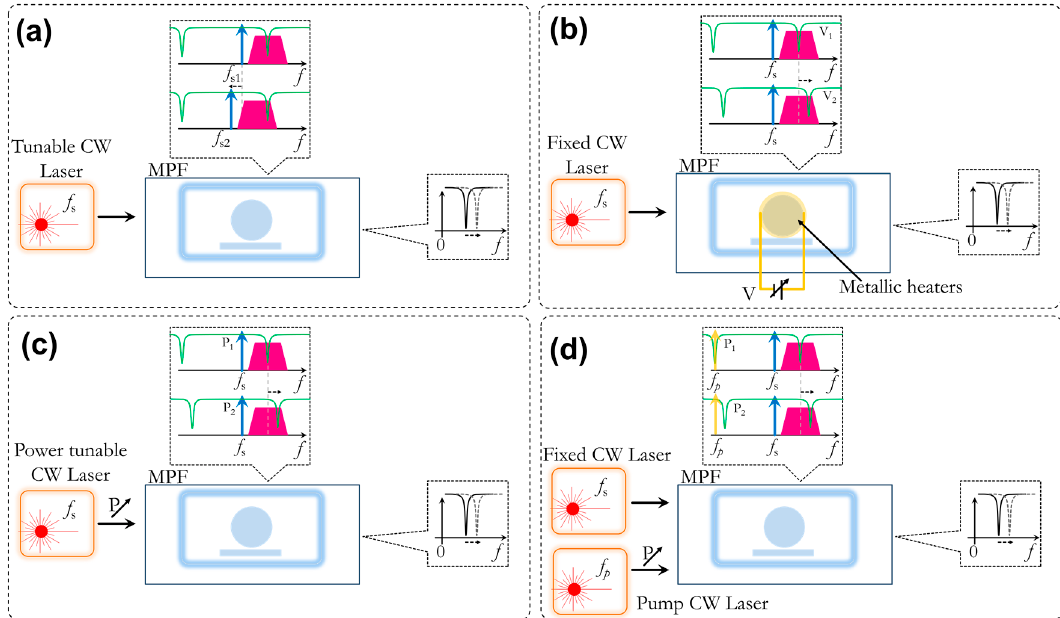
Figure 16. General frequency-tuning mechanisms for MPFs. ( a ) Tuning the optical carrier wavelength using a wavelength-tunable continuous wave (CW) laser. ( b ) Thermally tuning the resonance wavelength of the micro-resonator. Optically tuning the resonance wavelength of the micro-resonator using adjusting ( c ) the carrier light, and ( d ) pump light power levels.